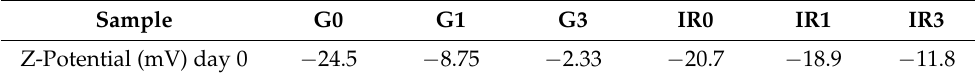
Table 1. Z-Potential values.